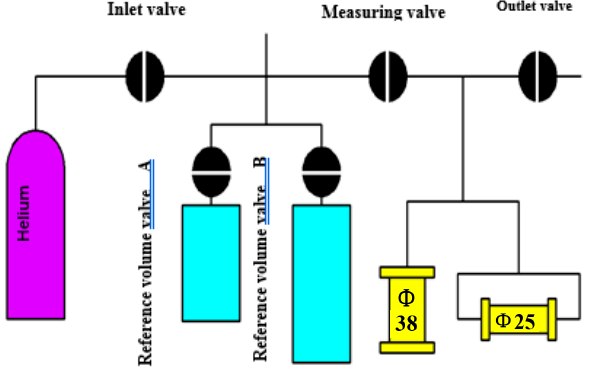
Figure 7. Helium porosity measurement instrument diagram.